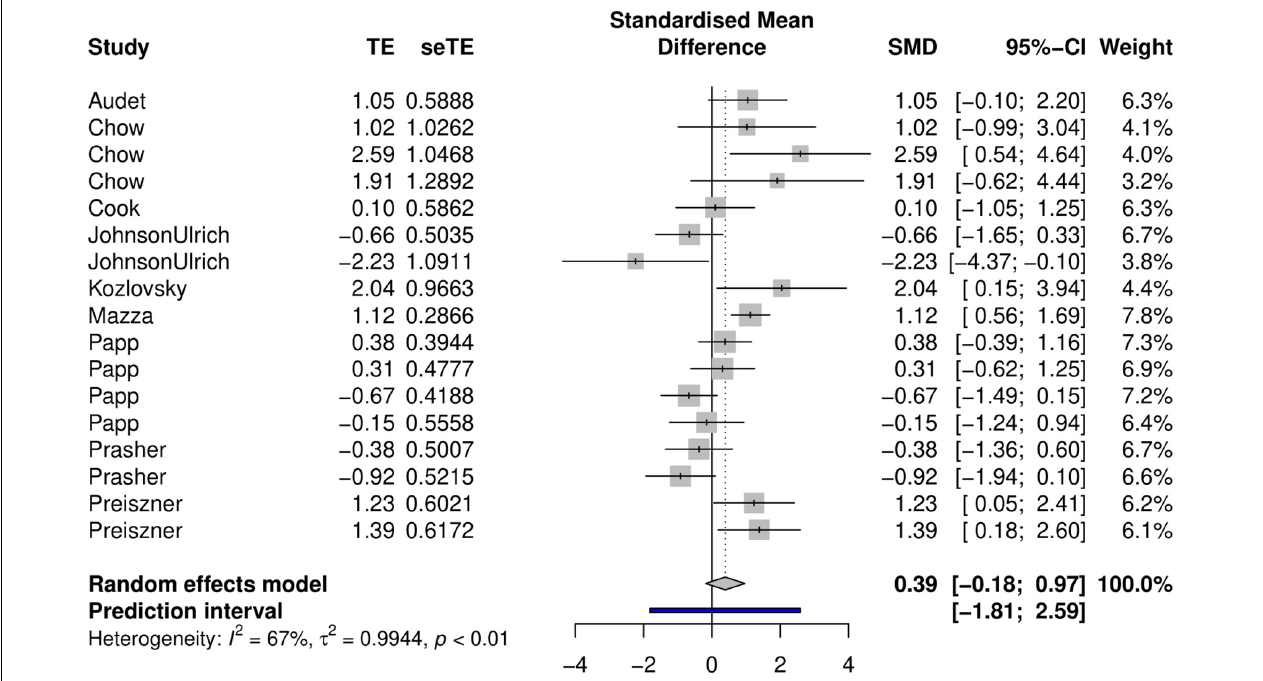
FIGURE 2 | Forest plot showing effect sizes (logarithmic odds ratios indicating the difference in problem-solving success between urban and rural animals) with 95% confidence intervals. Positive effect size values indicate that animals from urban environments were more successful problem-solvers, whereas negative values indicate better problem-solving abilities in rural